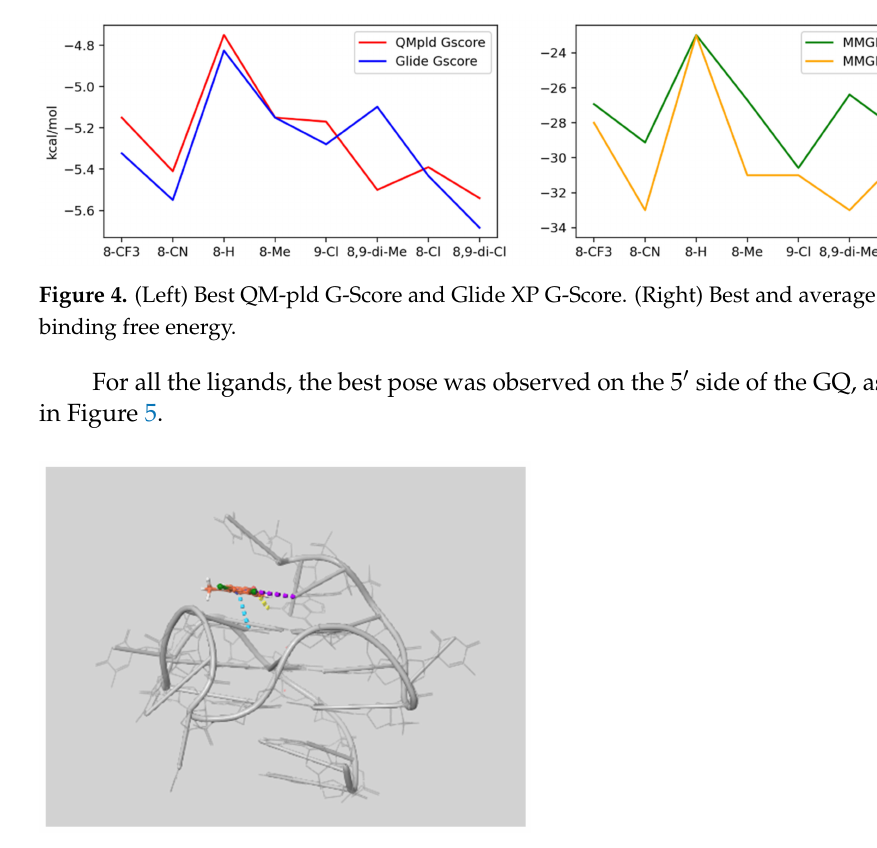
Figure 5. Interaction between the ligand 8,9-di-Cl and c-myc at the 5 (cid:48) end of the GQ. Dashed lines highlight specific interactions according to the following color code depending on the nature of the interaction: hydrogen bond (yellow), π - π (light blue), and halogen bond (purple). Carbon atoms of the ligand have a brown color, while Hydrogen atoms are white, Oxygen red, Nitrogen blue, Chlorine green, and all atoms on DNA